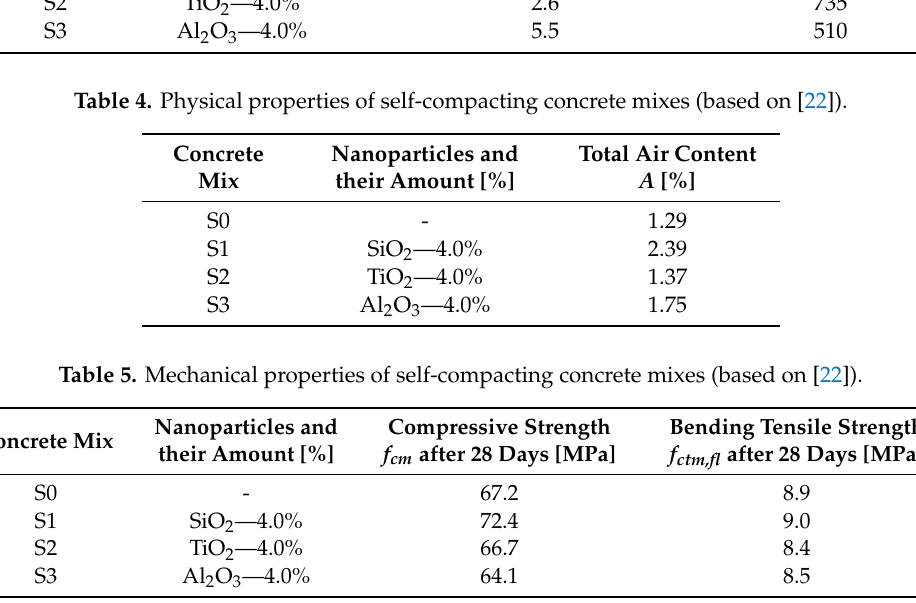
Figure 8. ( a ) Indenter immersion curves for all the indentation phases, ( b ) indenter immersion curves for the creep phase only, ( c ) mean ( μ ) indenter immersion for all the indentation phases ( σ means one standard deviation), and ( d ) average immersion for the creep phase only. Reference sample S0.